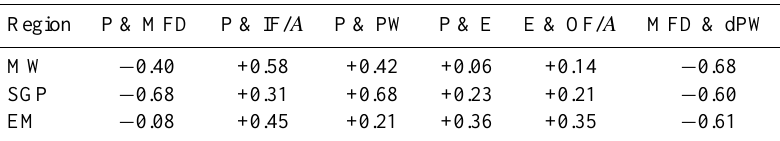
Table 4. Linear correlation coefficients between WVB components for the MW, SGP, and EM regions. Using a 2-tailed t test that accounted for non-independence of the data (see Zangvil et al., 2001; Jin and Zangvil, 2009), the 95% (99%) confidence levels for each region are